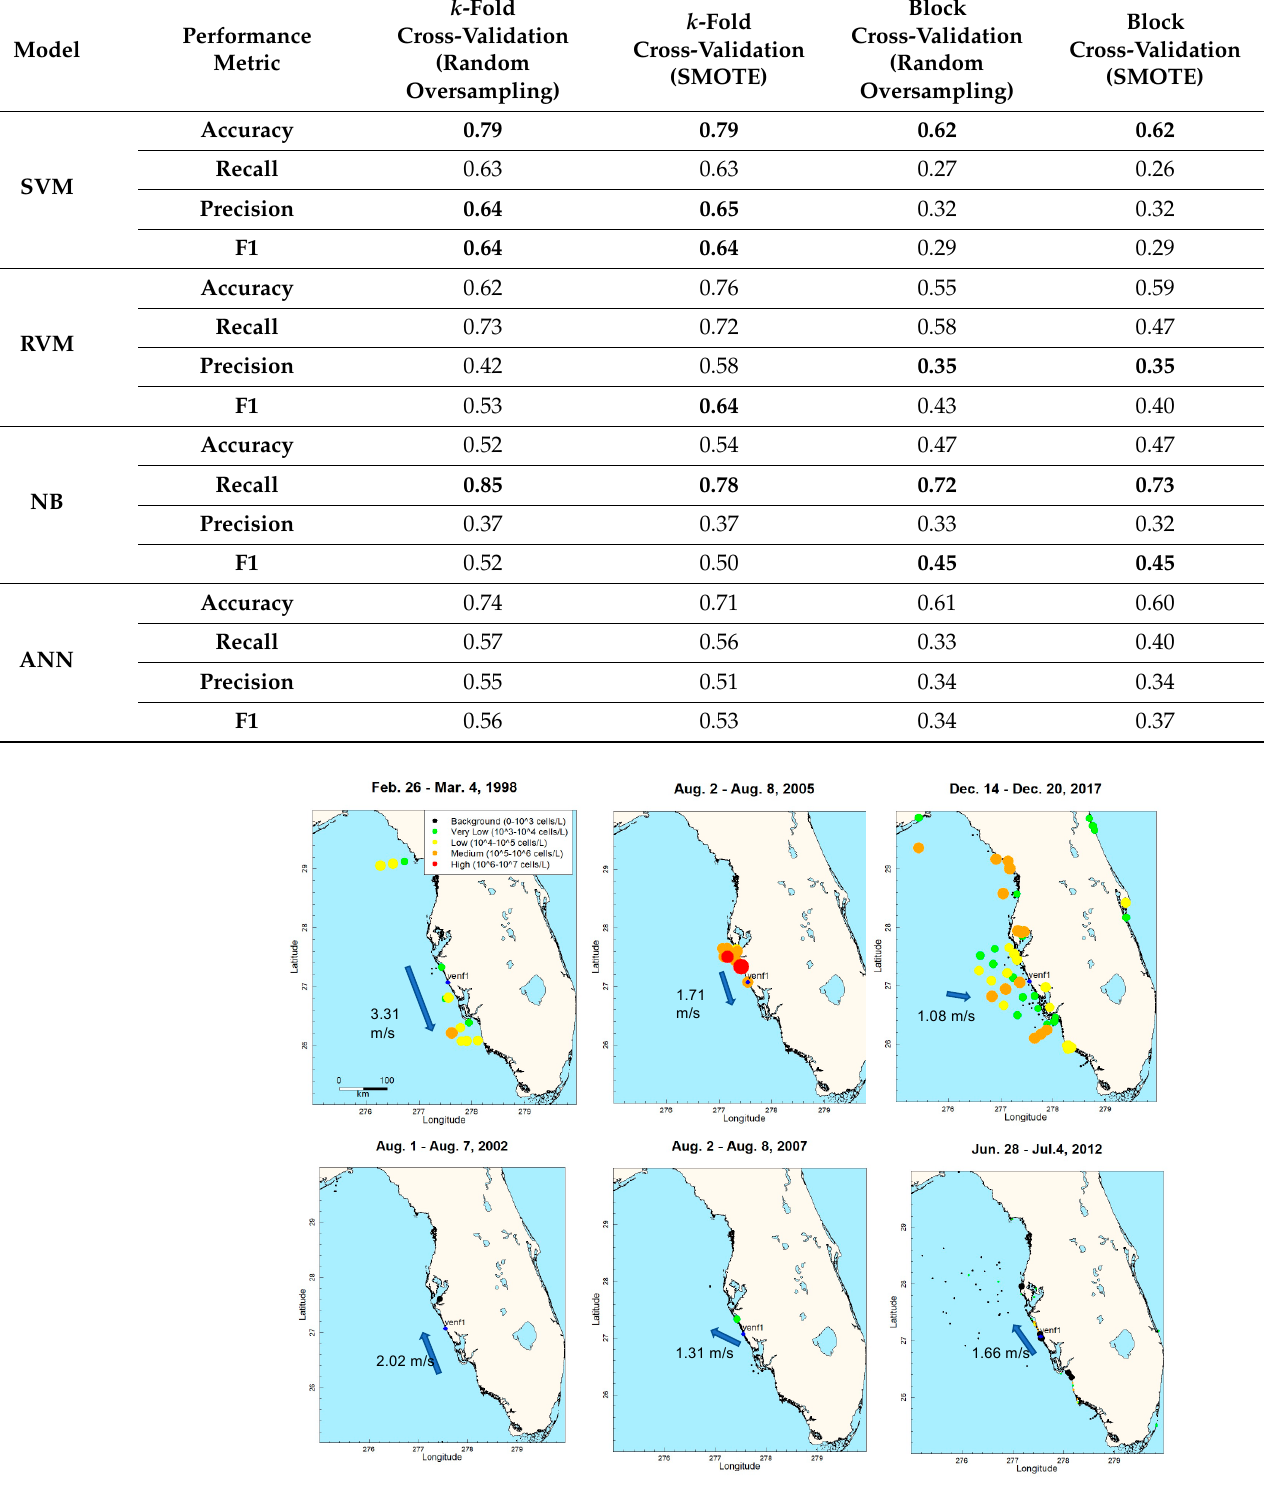
Figure 6. Probability of Karenia brevis as a function of wind speed and direction, obtained from the sensitivity analysis using the RVM. 3.3. Role of river flow and associated nutrients Seasonally, riverine flow typically increases for all rivers in all years during the sum- mer months, but interannual variability is high (illustrated for the 21 year record for the Suwanee, Peace, Myakka, and Hillsborough Rivers, Figure 7a). For all rivers, and across all discharge levels examined, the probability of K. brevis blooms increased with river flow (Figure 7b). For all rivers, bloom probability predicted by the NB was always greater than that predicted by the RVM, which was always larger than that predicted by the SVM (Figure 7b). This result can be explained by Table 1: the NB had the highest recall value; the RVM ranked second; the SVM had the lowest value. The ANN was excluded from the sensitiv- ity analysis because the ANN yields probability predictions that are either very close to 0 (<0.01) or 1 (>0.99. This presents numerical instability issues when computing the weights